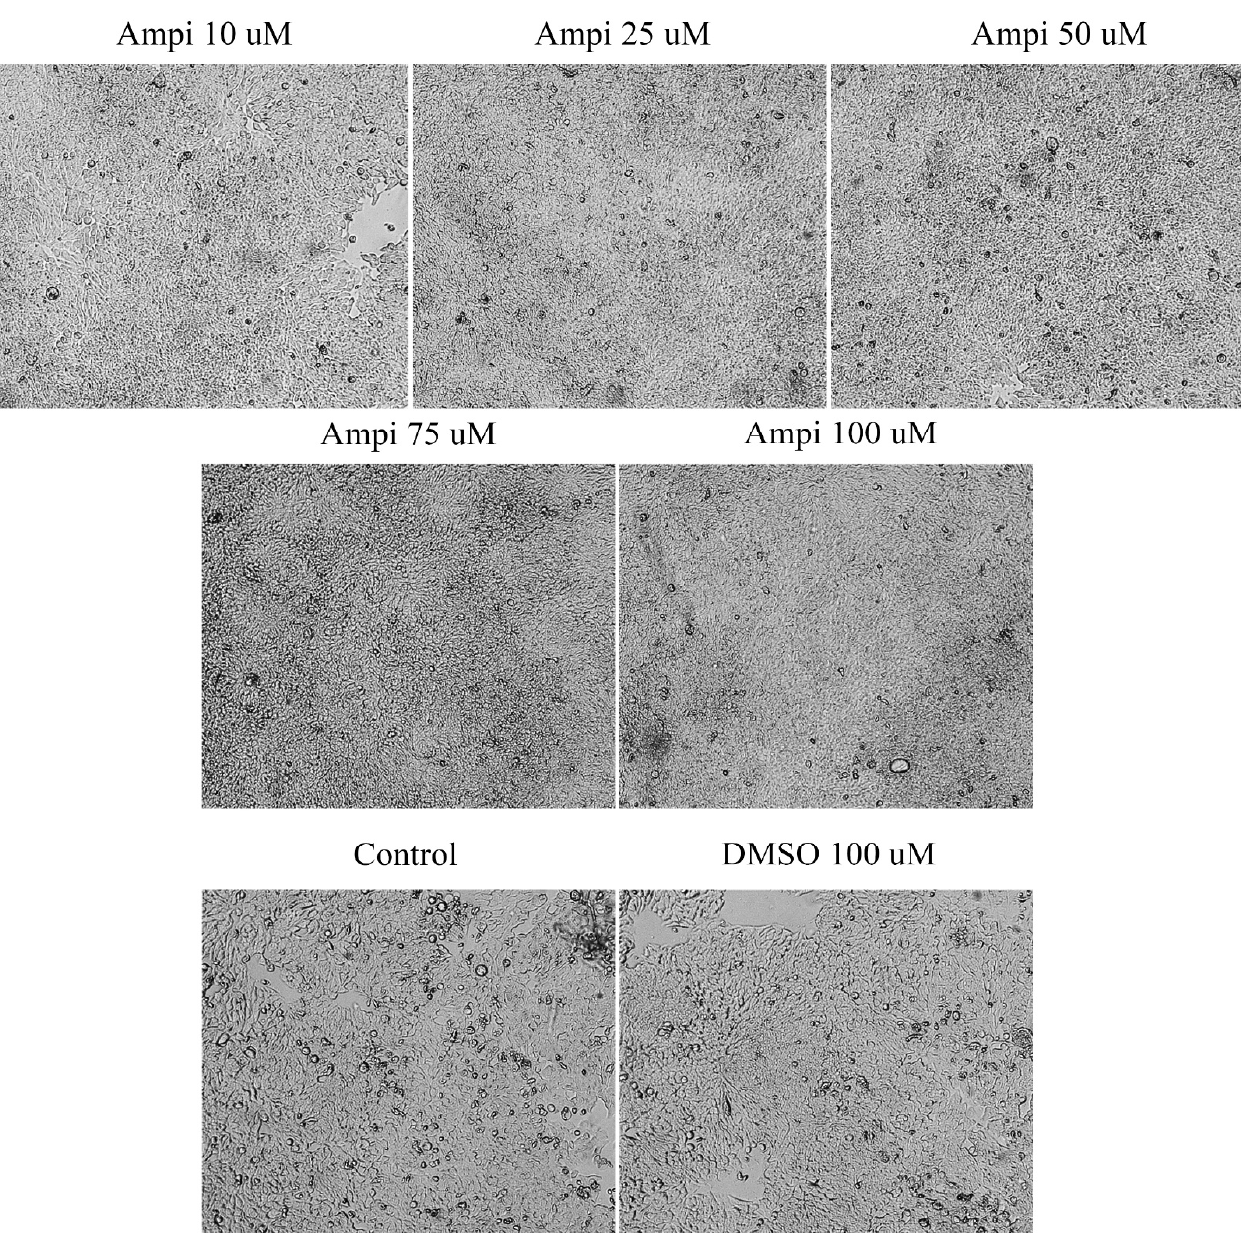
Figure 4. Morphological and shape changes produced by ampicillin in HT-29 after 72 hours of treatment. 20× magnifica- tion.